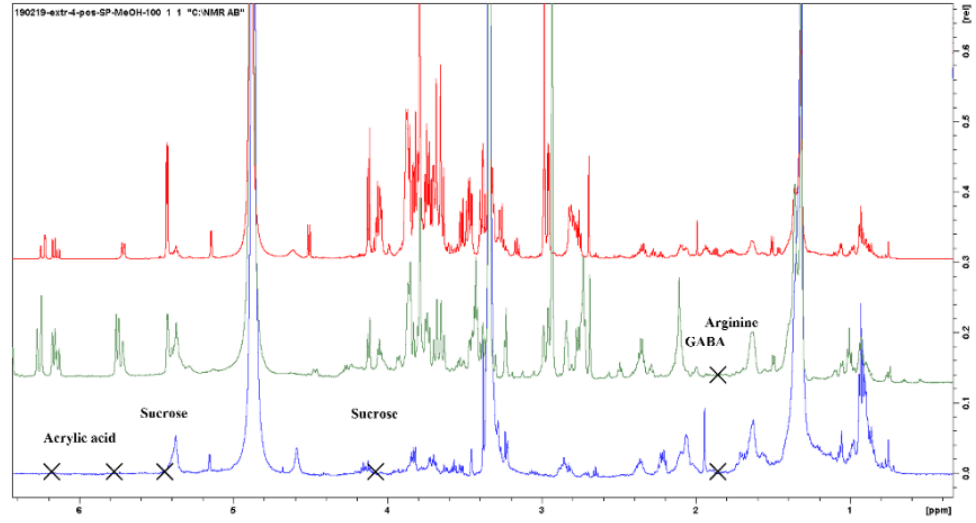
Figure 6. Comparison of 1D NMR spectra of alcoholic extracts of roots (CH 3 OH 100%) (red signal), leaves (green signal), and residues (blue signal) of Posidonia oceanica .